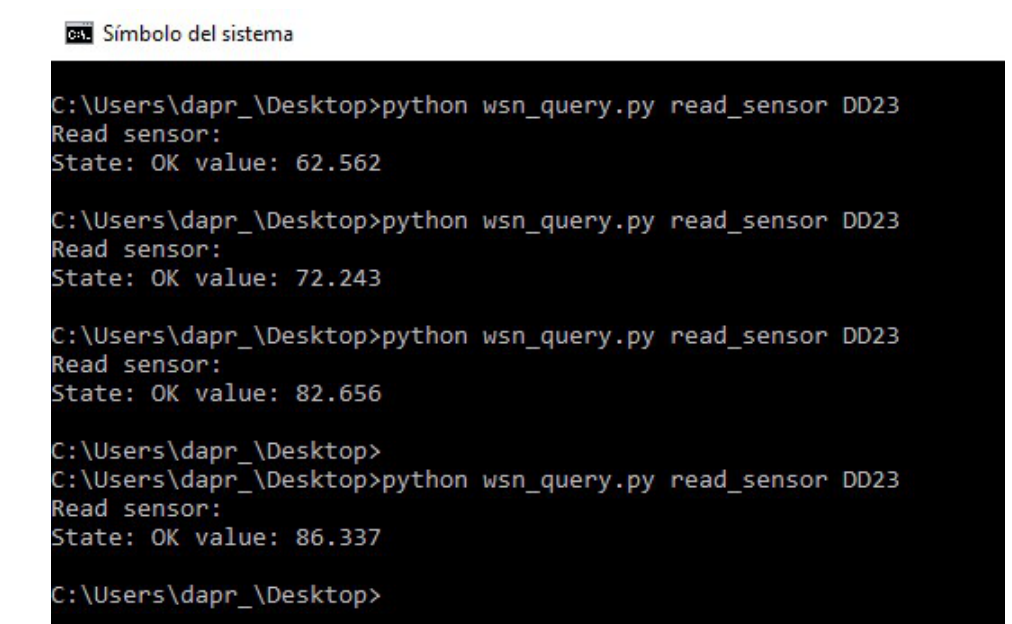
Figure 3. Example of noise sensor value request with MAC address DD23. Table 2. In-Room System Sensor